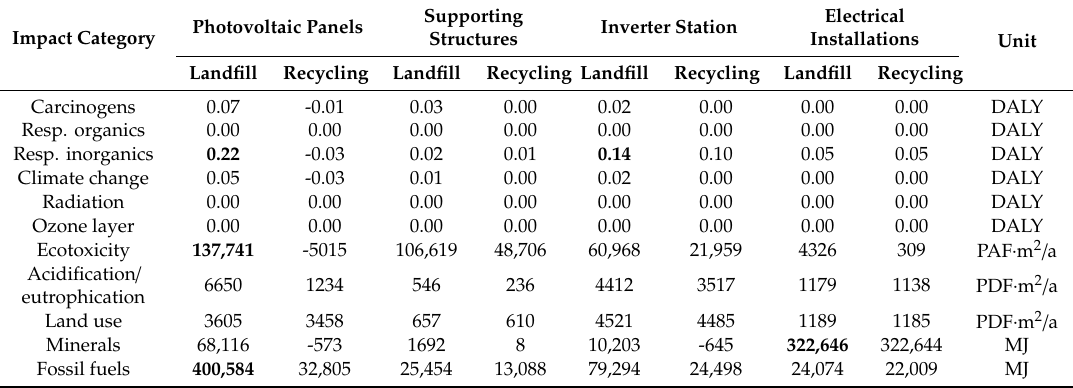
Table 2. Results of characterization of environmental consequences, occurring in the life cycle of selected groups of 1 megawatt photovoltaic power